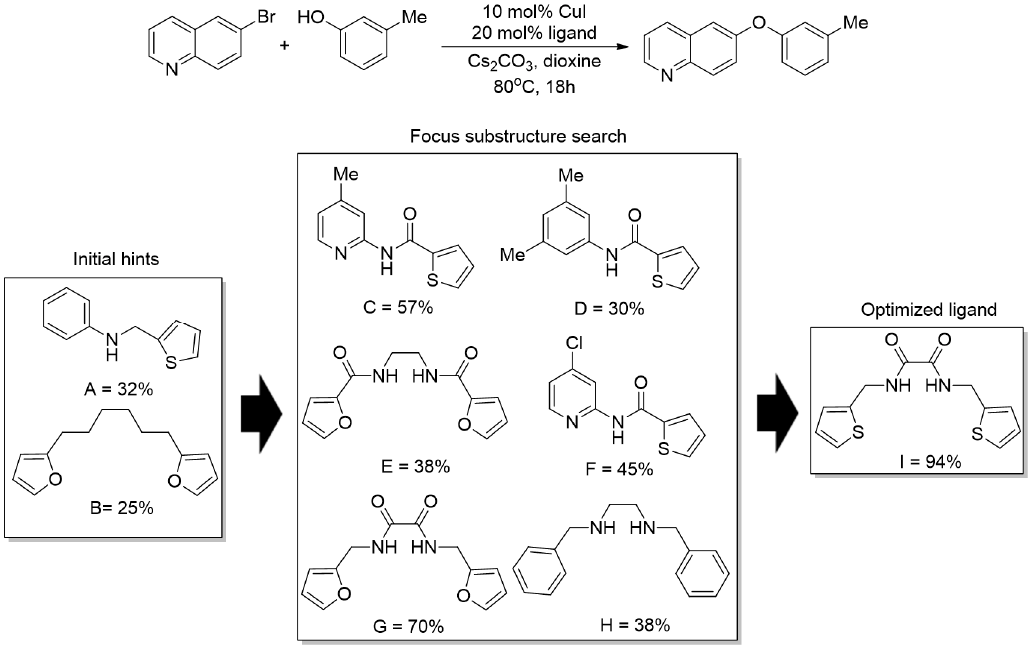
Figure 15. Method for utilizing the AbbVie compound library as an origin for finding, recognition, and development of new